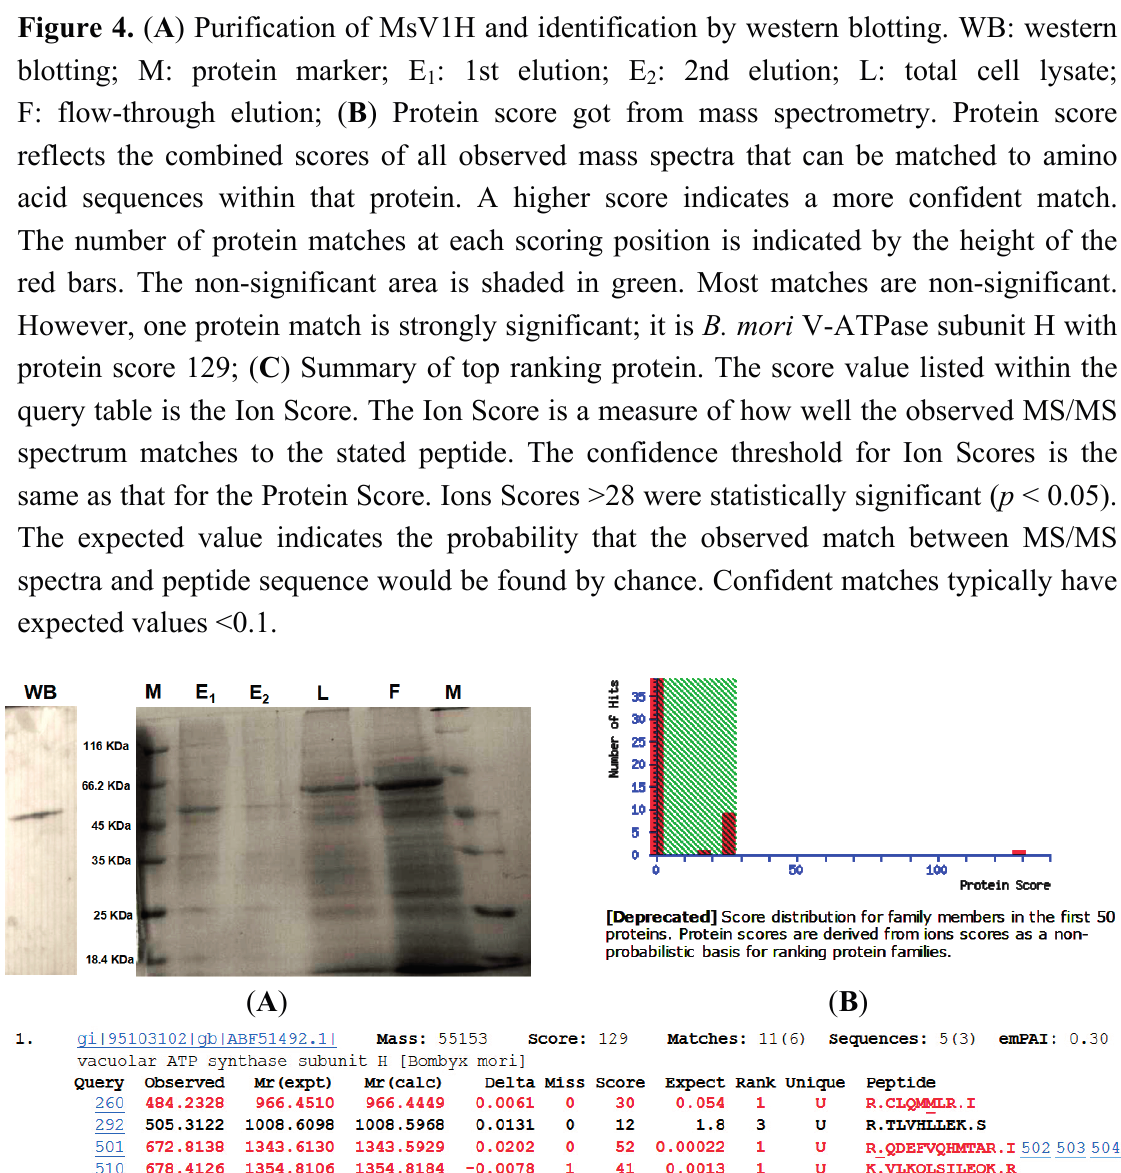
Figure 4. ( A ) Purification of MsV1H and identification by western blotting. WB: western blotting; M: protein marker; E